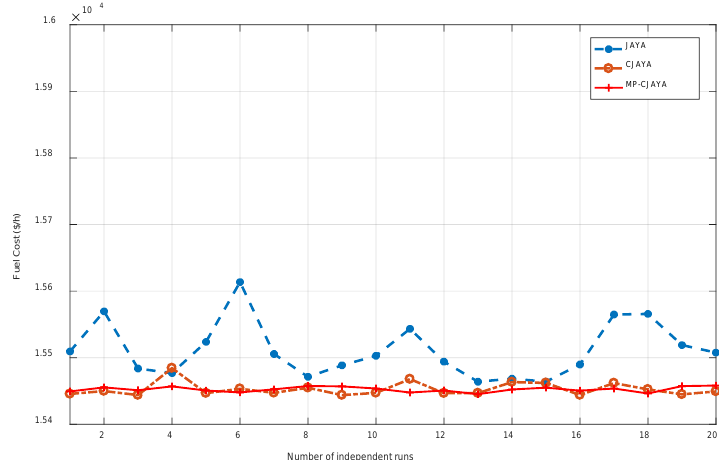
Figure 8. Fuel cost for 20 independent runs of 6-units system ( P D = 1263 MW).